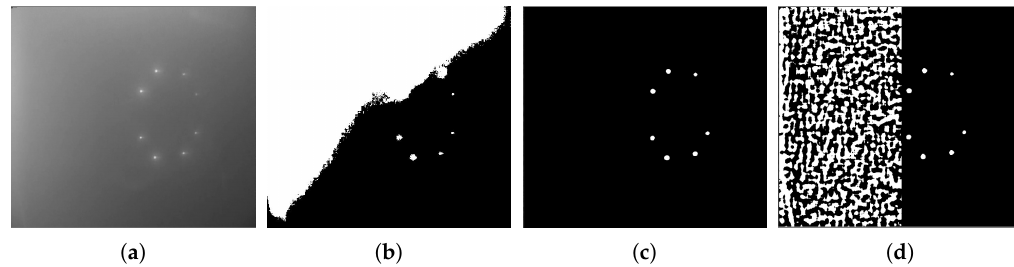
Figure 8. ( a ) Original image. ( b – d ) Results obtained by using the method in the first, second, and third row of Table 2, respectively. Table 2. Detection performance of various